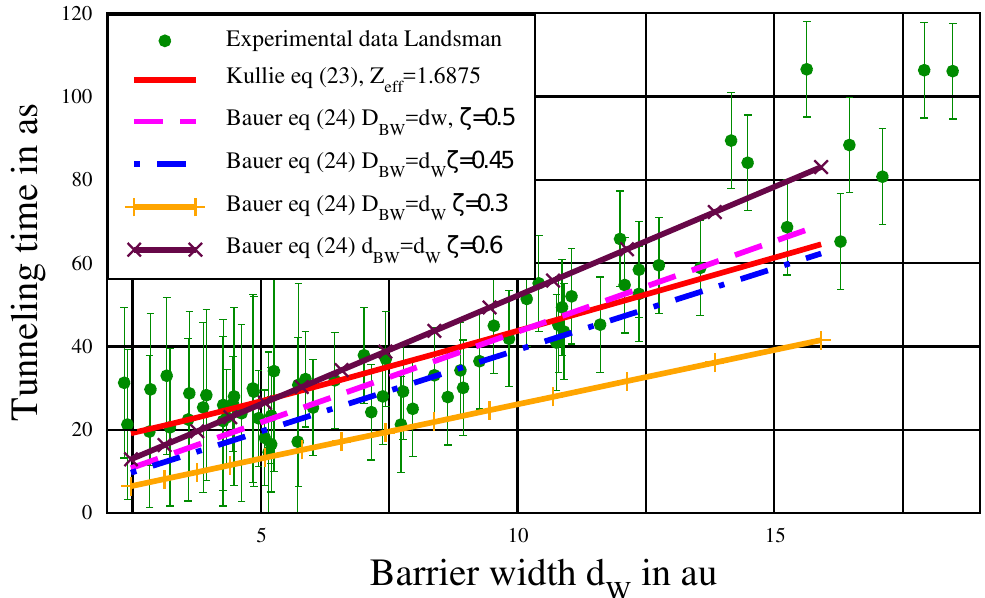
Figure 2. (Color online) Graphic display. The x -axis is the barrier width d W in au and the vertical axis the tunneling time in as of formula Equation (23) Υ K ( d W ) , and of formula Equation (24) Υ B ( D BW = d W ) with ξ = 0.3,0.45, 0.5,0.6. The experimental data are also shown, at the corresponding barrier width d W with the error bars. See [3]. The experimental data were kindly sent by Landsman; see [6]. For clarity, we plot in Figure 3 a copy of Figure 1 of [1] (extracted data by using a web digitizer), i.e., the data of Bauer Υ B ( D BW = d C ) for ξ = 0.45 (dashed, black) and also the FPI (solid, light blue), which was used by Bauer after it was extracted from Figure 3d of [6]. Additionally, we plot Υ B ( D BW = d C ) with ξ = 0.45 (dashed doted, magenta), which as expected, reproduce the line of Bauer (dashed, black); the tiny difference is only because we extracted the data of Figure 1 of Bauer [1]